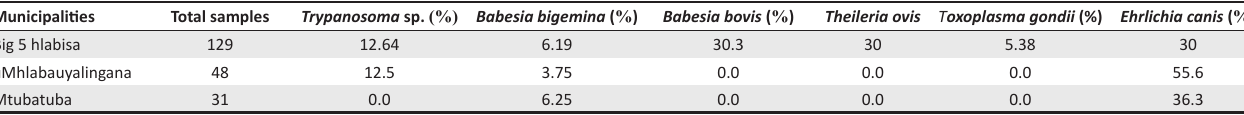
TABLE 3: Infection rate of parasites from different municipalities. Municipalities Total